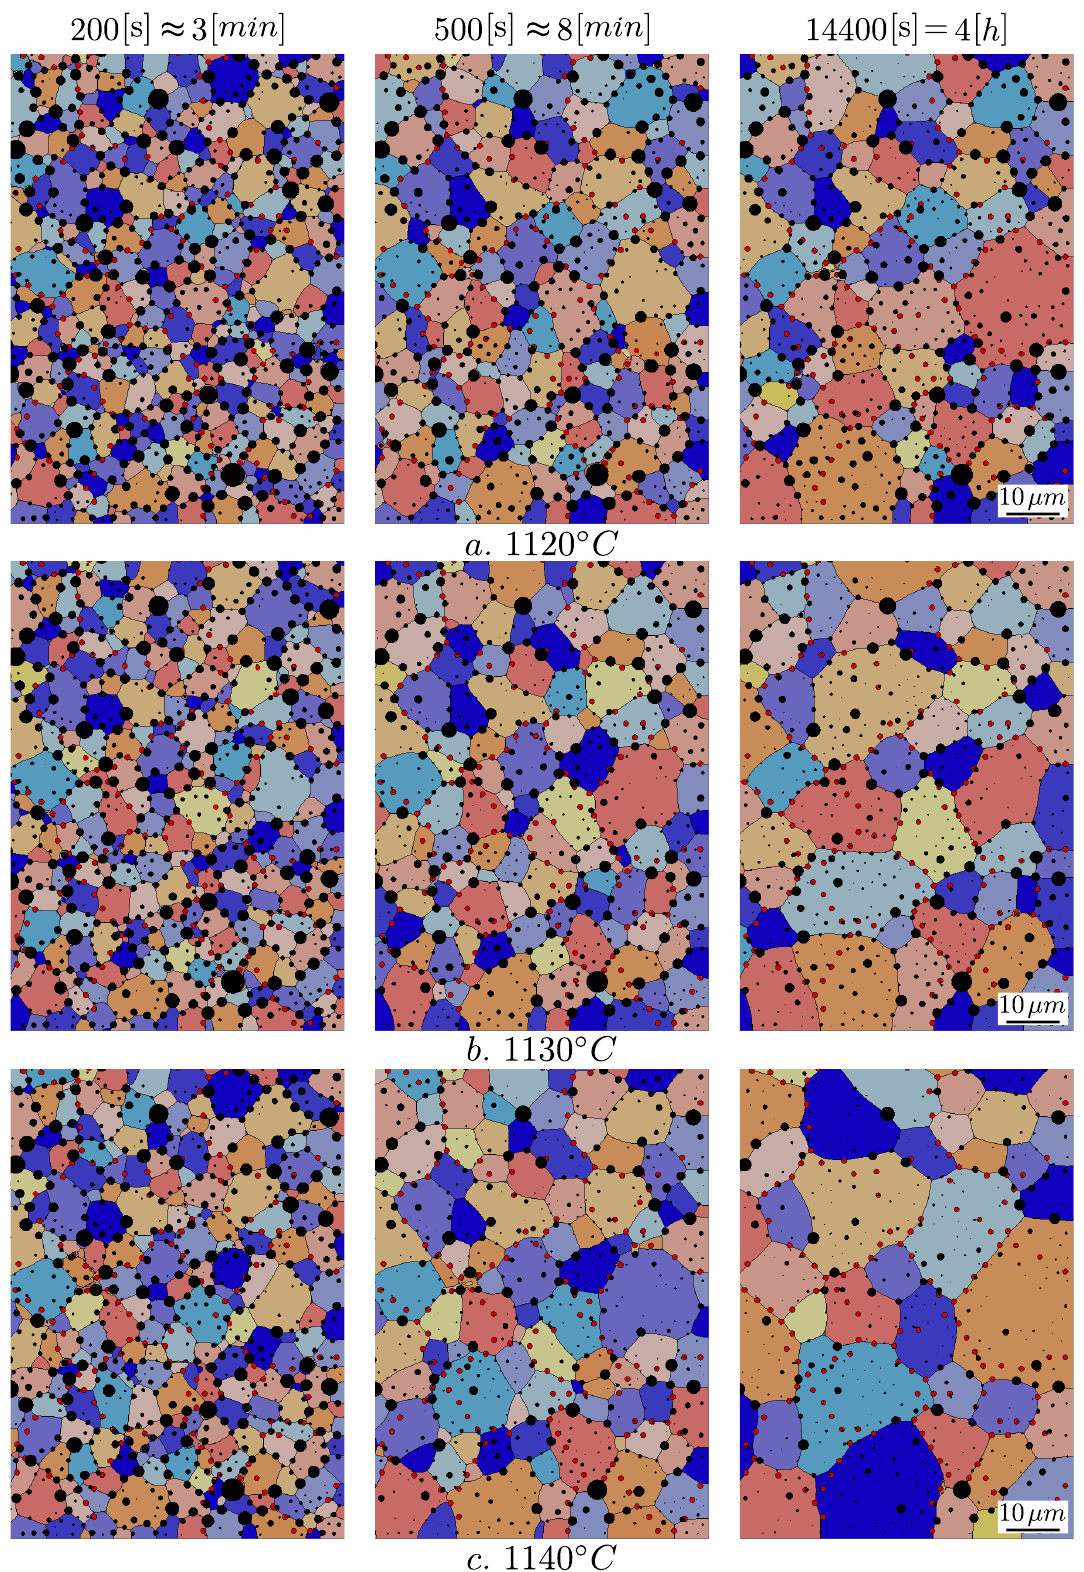
Figure 17. GG simulations for the N 19 material with both evolving primary γ (cid:48) precipitates (black) and static PPB particles (red) at subsolvus temperatures for different heat treatment and times (200 s, 500 s, and 14,400 s) for a zoomed area of the 0.5 mm × 0.5 mm simulation